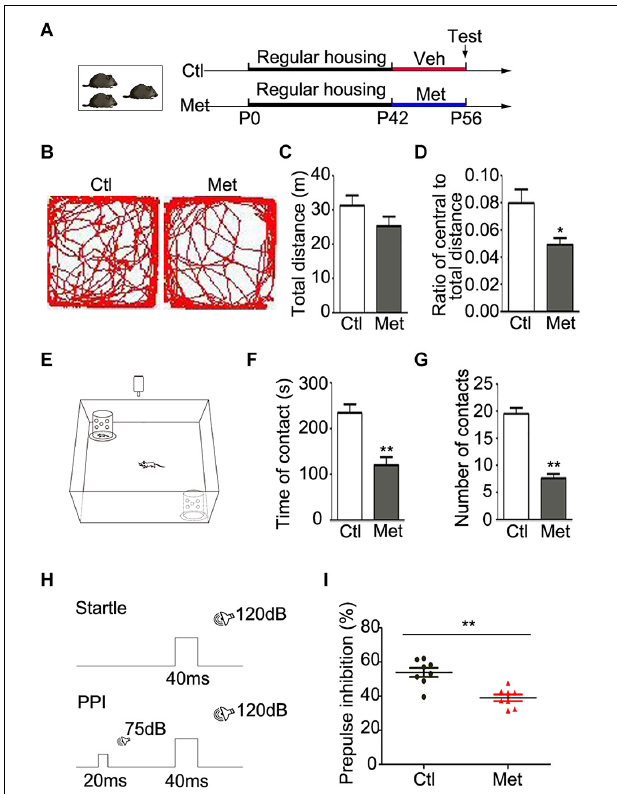
FIGURE 1 | Analyses of behavioral changes in mice after Met treatment. (A) The experimental paradigm of drug treatment. (B) Representative pictures showing the path of traveling in the open field test. The total distance (C) and the ratio of central/total distance (D) in open field were detected in vehicle-treated mice (Ctl) and Met-treated mice (Met) ( n = 14 for each group). (E) The experimental paradigm of social interaction test in Ctl and Met group. The total duration of social contacts (F) and the number of social contacts (G) were detected in social interaction test ( n = 10 for each group). (H) The experimental paradigm for monitoring PPI in Ctl and Met group. (I) The pre-pulse inhibition of acoustic startle response ( n = 8 for each group). The data are expressed as the mean ± SEM. * P < 0.05; ** P <